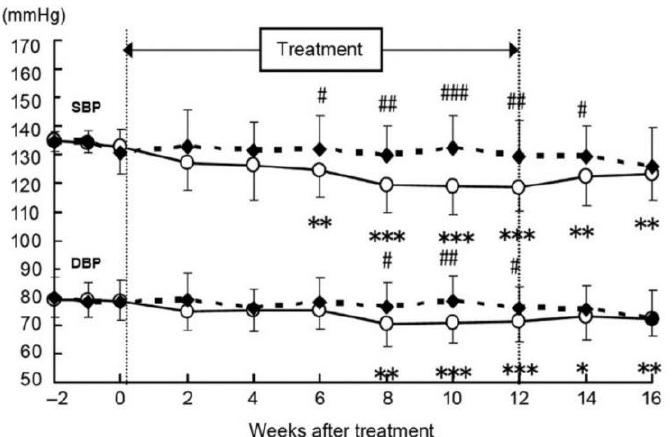
Figure 8. Change in the systolic blood pressure (SBP) and diastolic blood pressure (DBP) in high normotensives humans. ○ : test beverage group (n = 21), ◆ : placebo group ( n = 22). The values are expressed as the mean ± S.E. Significant differences are as follows: # p < 0.05, ## p < 0.01, ### p < 0.001, compared with placebo-meal (control) group using a Student's t -test; * p < 0.05, ** p < 0.01, *** p < 0.001, compared with values on day 0 after intake (initiation day) using Bonferroni’s multiple rank-sum test.